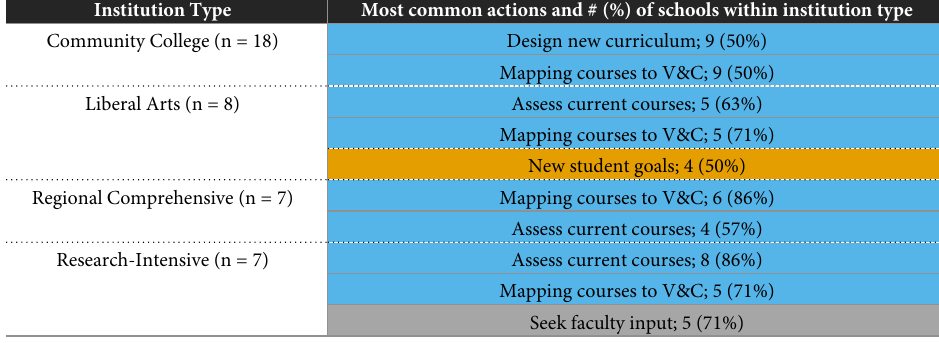
Table 1. Actions taken by institution type across cohorts 1–3 as reported on posters at NBIO (n = 40 posters with action data). Each action was reported by at least two different schools. (blue = dept./institution level, grey = faculty level, orange = student